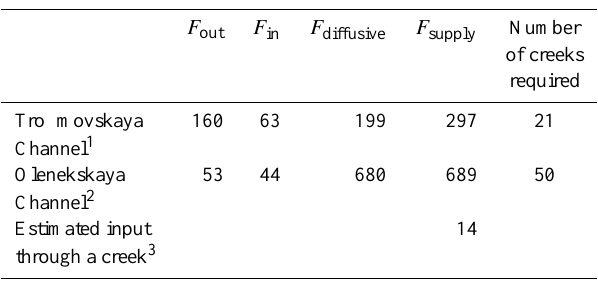
Table 1. Methane budget for sections of the Lena River (in kmold − 1